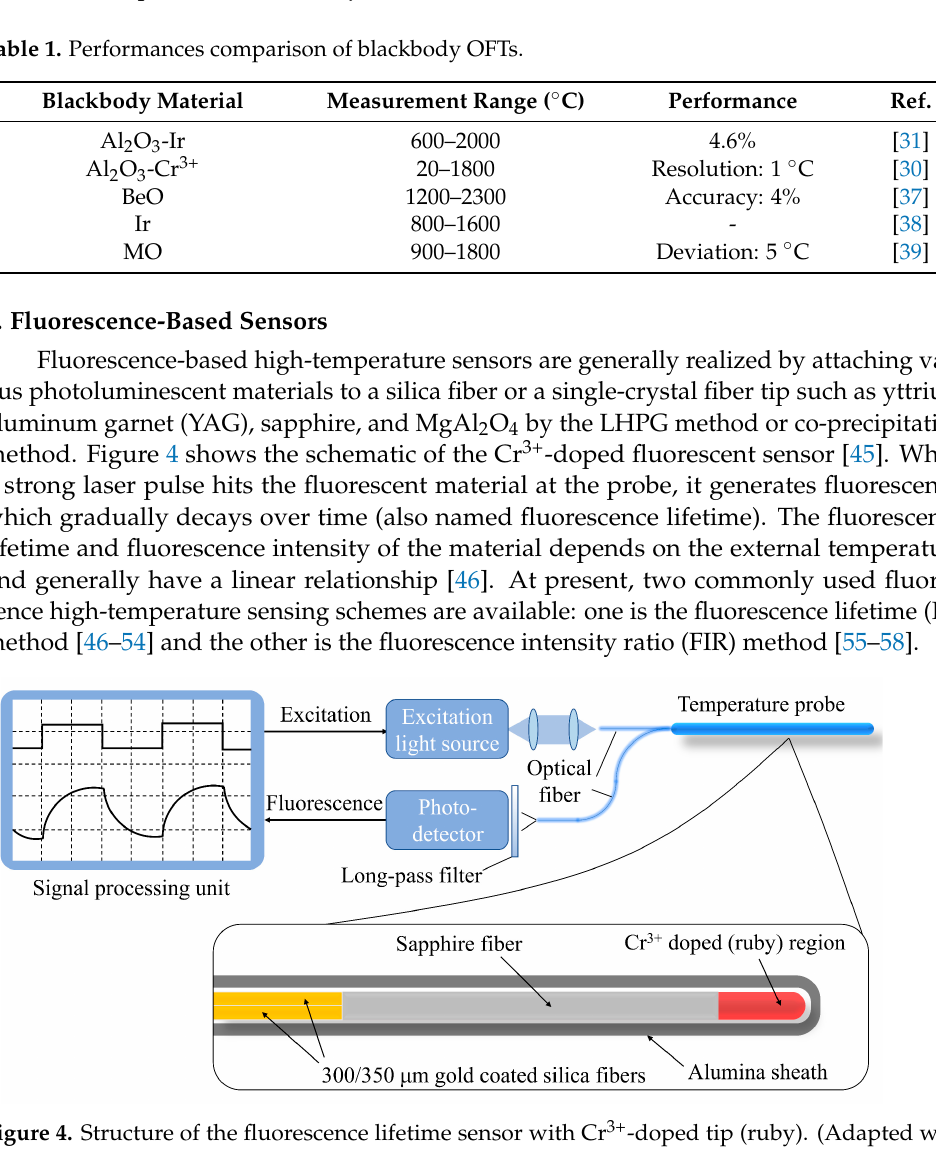
Figure 4. Structure of the fluorescence lifetime sensor with Cr 3+ -doped tip (ruby). (Adapted with permission from Ref. [45]).